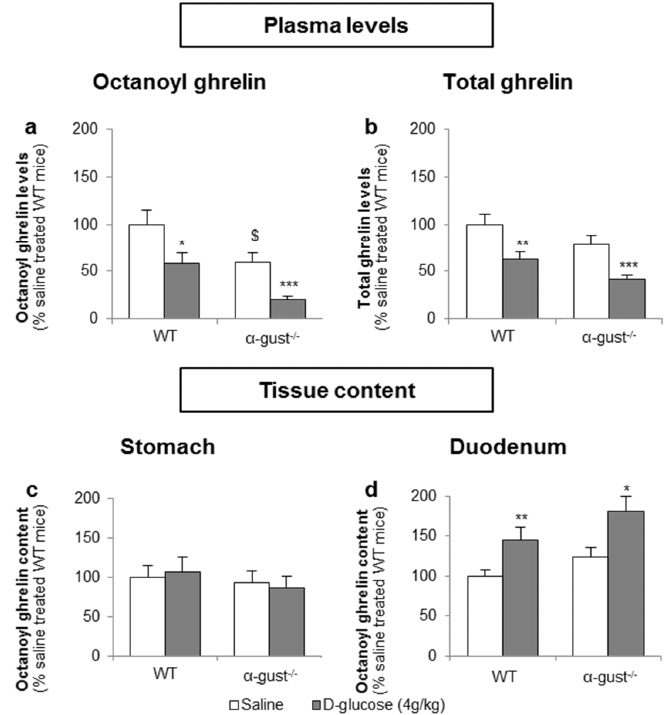
Figure 6. The inhibition of plasma ghrelin levels after an intragastric administration of D -glucose originates mainly from duodenal ghrelin cells. WT and α‐ gust − / − mice were gavaged with D ‐ glucose (4 g/kg, n = 8) or saline ( n = 13). Ghrelin levels were determined in ( a , b ) plasma, ( c ) stomach and ( d ) duodenum, 40 min after administration. Results (predicted values ± standard error of the predicted values) are expressed relative to the control stimulation (saline treated WT mice). * p < 0.05, ** p < 0.01 and *** p < 0.001 vs. saline, $ p < 0.05 vs. saline ‐ treated WT mice.